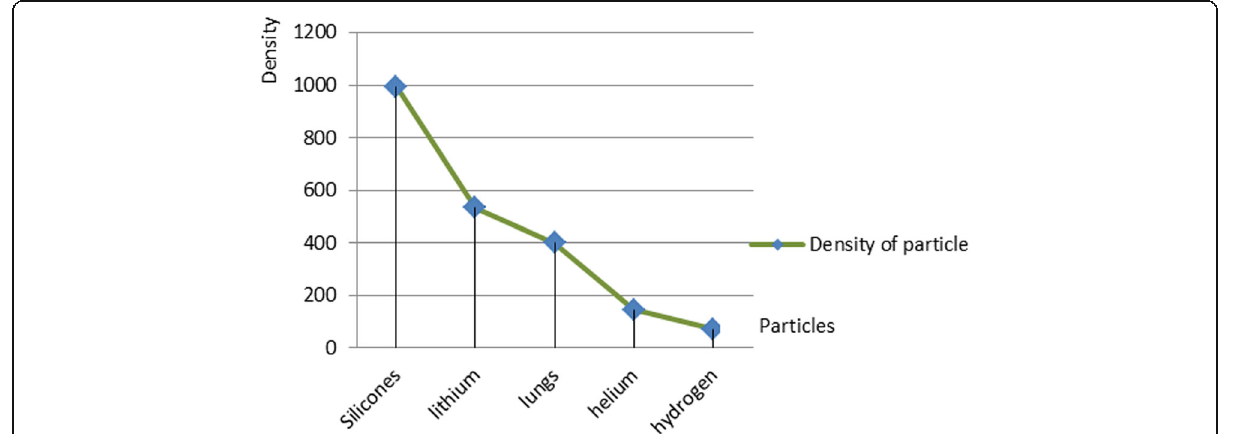
Fig. 4 Density of nanoparticles for the five selected